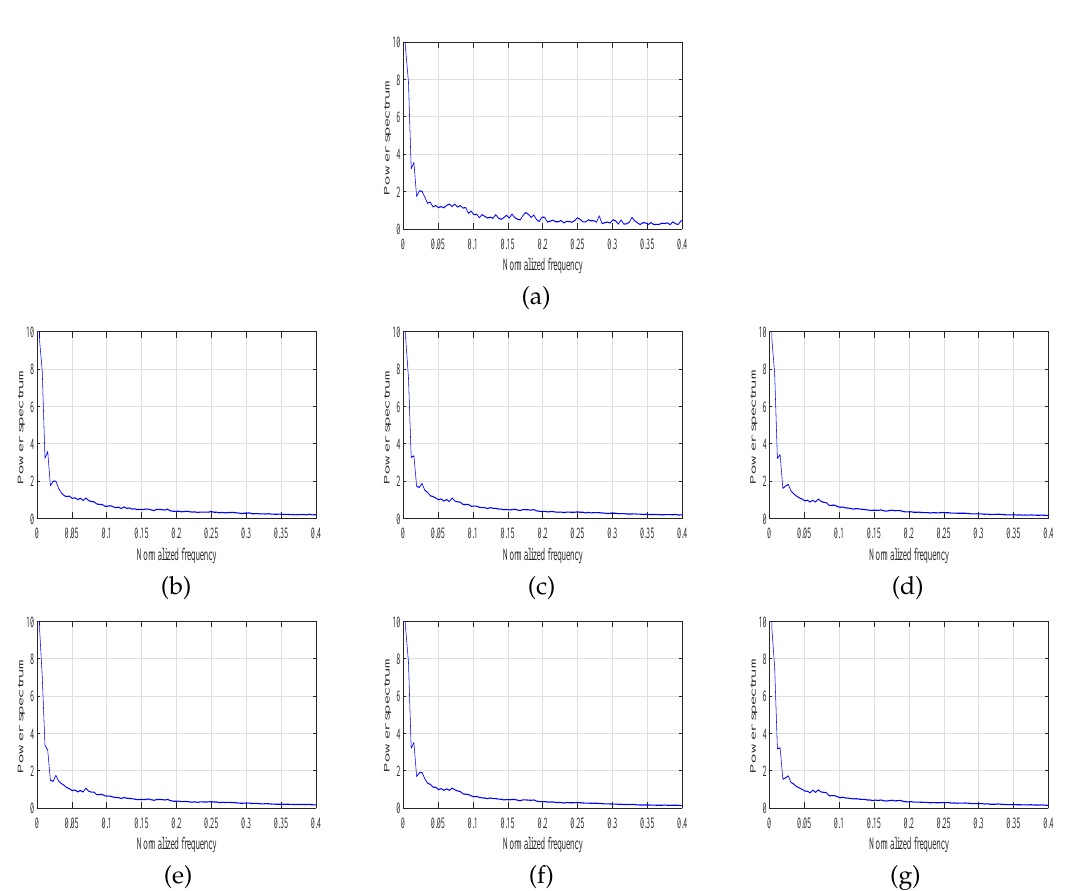
Figure 12. Power spectral for the forth real example of Figure 7: ( a ) real image; and destriping results by: ( b ) WFAF; ( c ) SLD; ( d ) UTV; ( e ) GSLV; ( f ) LRSID; and ( g )